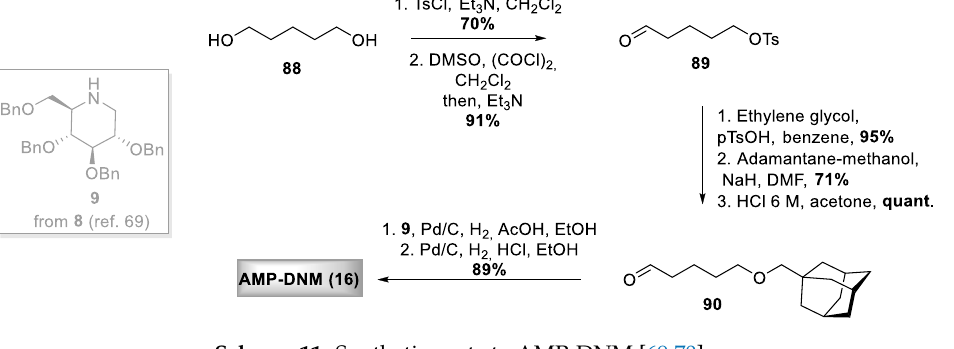
Figure 20. Effect of NBDNJ and AMP-DNM on NLGase inhibition in IB3-1 and CuFi-1 cells infected by P. aeruginosa. * p < 0.05; *** p < 0.001; ns, not significant. This figure is adapted from [173] published by PLOS.